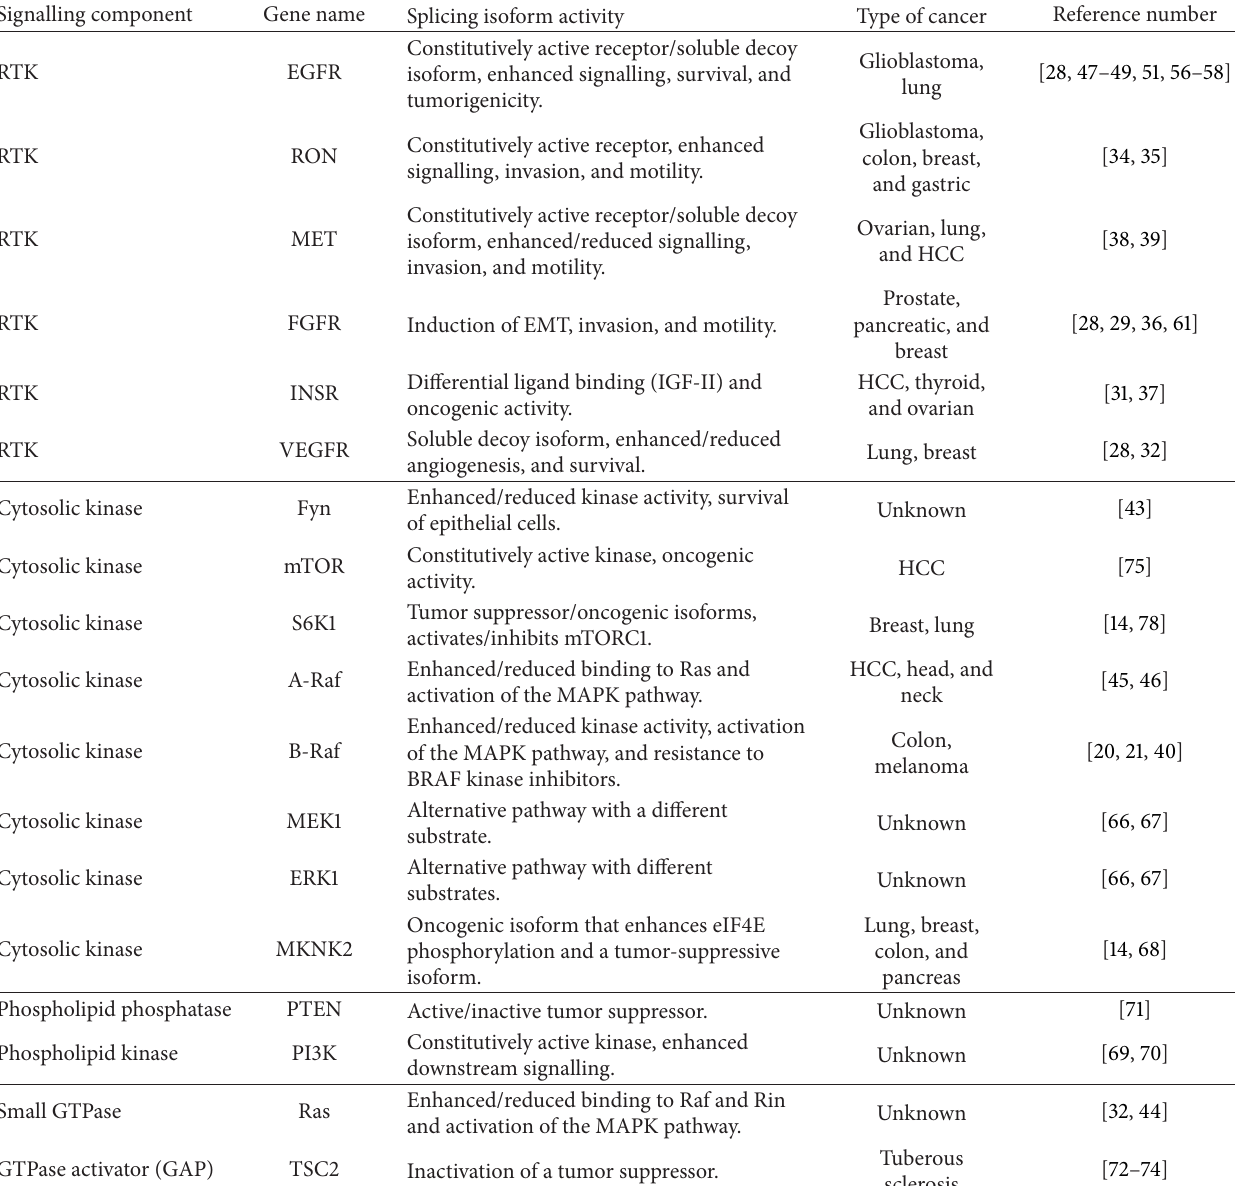
Table 1: Alternative splicing of Ras-MAPK and PI3K-mTOR signaling